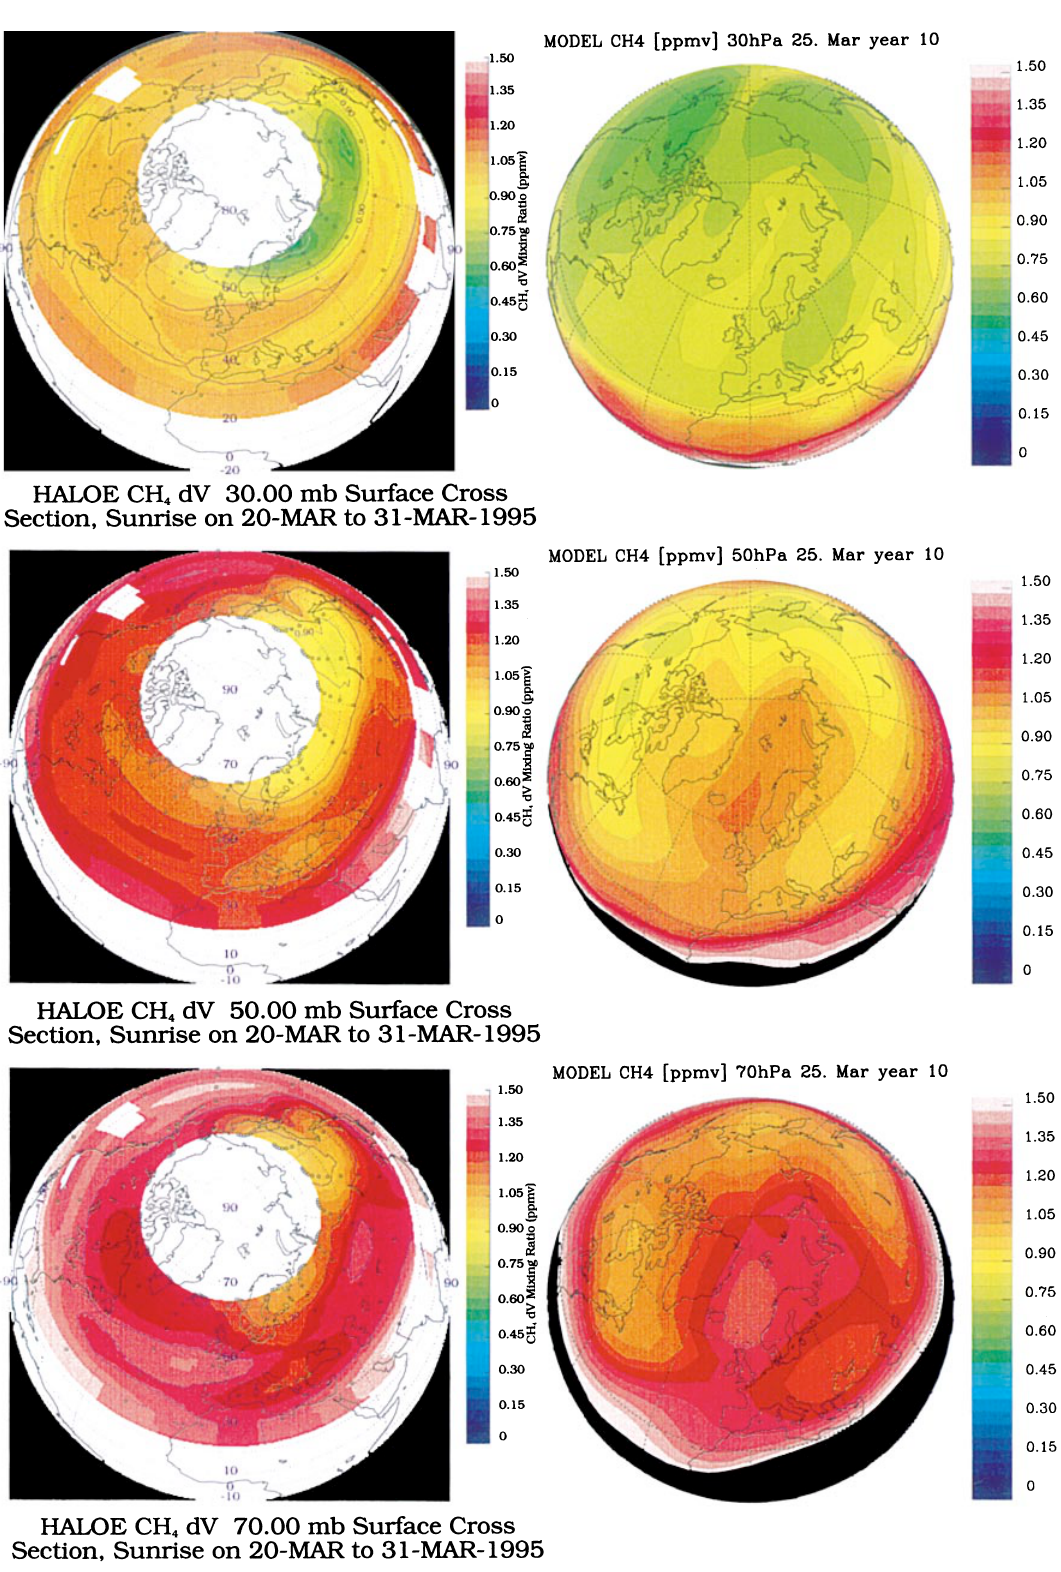
Fig. 10. Same as Fig. 7, but for methane (CH